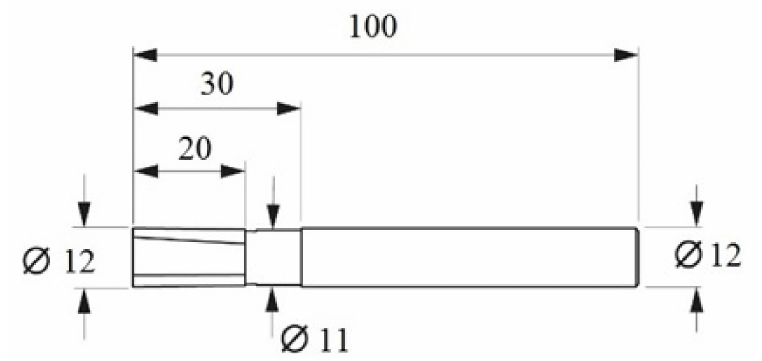
Figure 2. Twin blade shank cutter with PKD cutting edge [16].